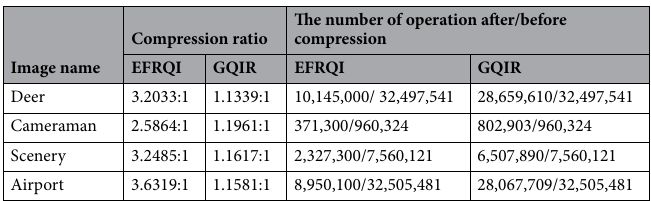
Table 4. Compression ratio comparison without considering preparation step.